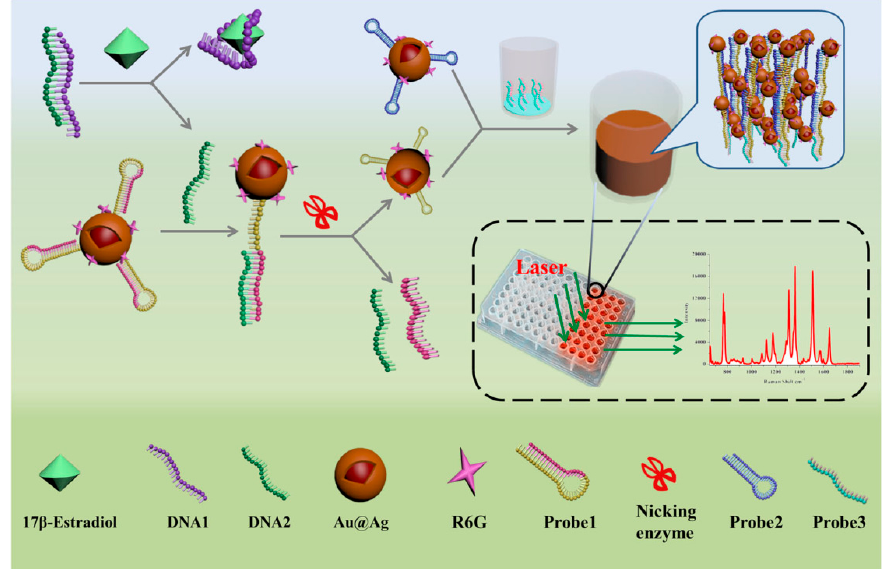
Figure 15. Schematic representation of aptamer-based SERS sensor for detection of 17 β -estradiol. (Reprinted with permission from Springer, 2019 [28]).